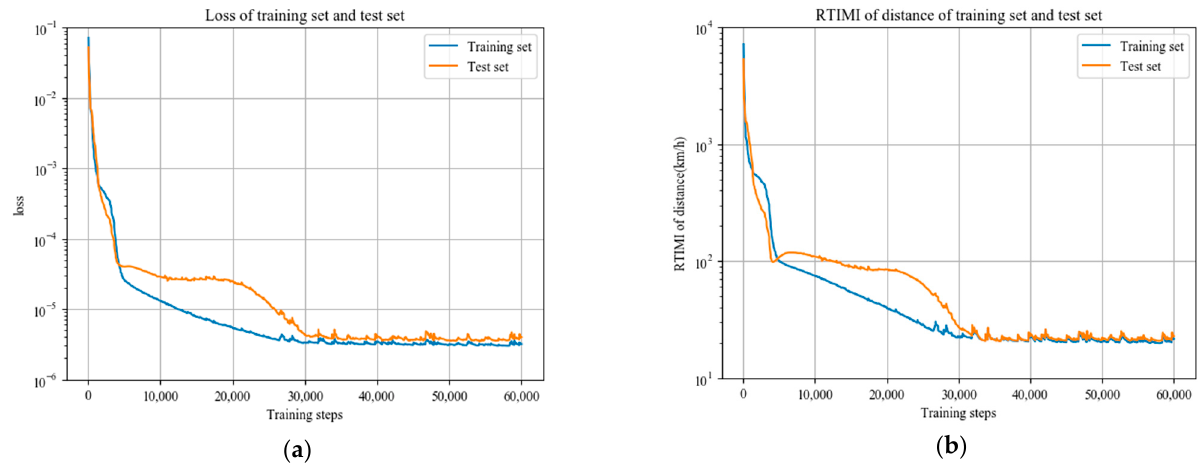
Figure 5. Training curves: ( a ) the loss function variation curve of the training set and test set; ( b ) the RTIME variation curve of the training set and test set. Table 1. Performance metrics of the training set and test set in the training process.